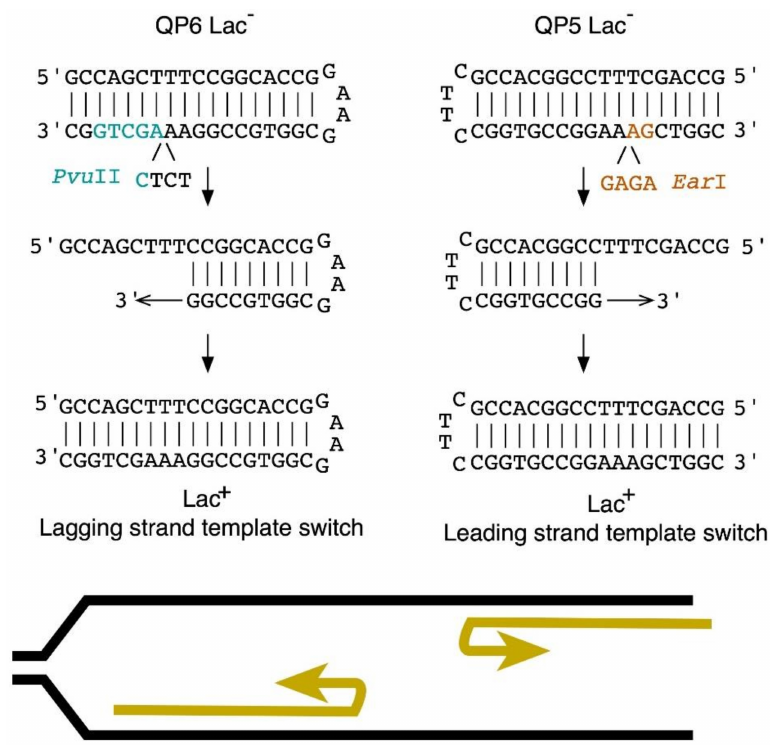
Figure 1. Template-switch reporter strains, QP5 and QP6. The sequence of the lacZ quasipalindrome is illustrated before and after Lac + reversion. The template switch misalignment is diagrammed below for QP6 on the lagging strand of replication, at the left, and for QP5 on the leading strand of replication, at the